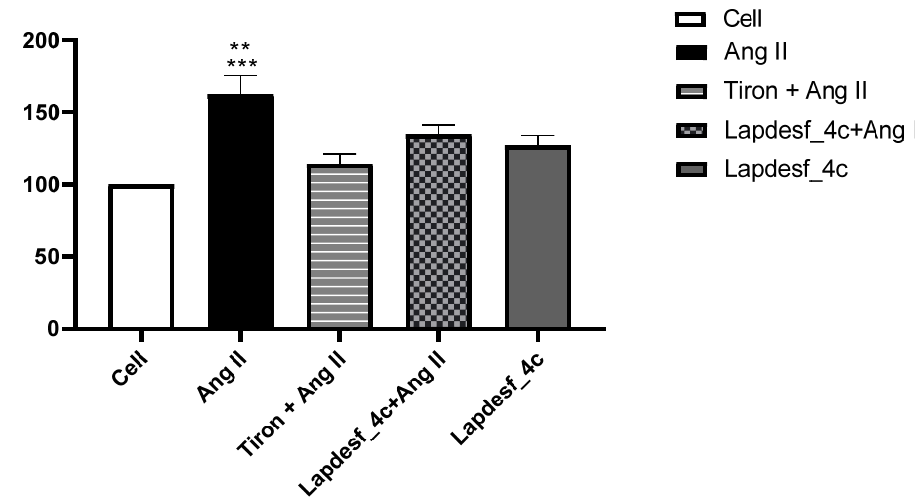
Figure 7. Percentage of fluorescence using lucigenin as probe after incubation of HUVEC cells with Ang II, Lapdesf-4c , and combined treatment ( Lapdesf-4c + Ang II) and (Tiron + Ang II). O 2 − detection, where ** p < 0.005 Ang II vs. 4c and 4c + Ang II. *** p < 0.001 Ang II vs. Tiron + Ang II.